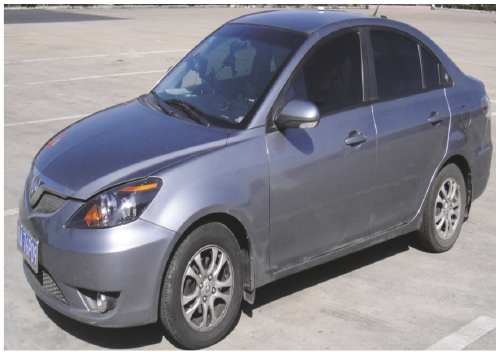
Figure 11: The subject